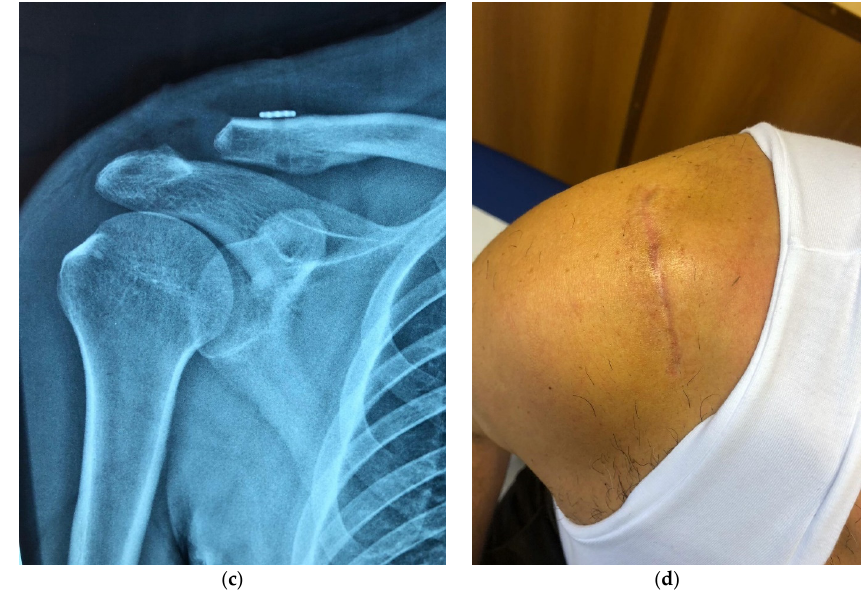
Figure 5. A clinical and radiological pre- and post-operative example. ( a ) preoperative x-ray, ( b ) clinical visualization of dislocation, ( c ) postoperative 3 months x-ray, ( d ) post-operative 3 months